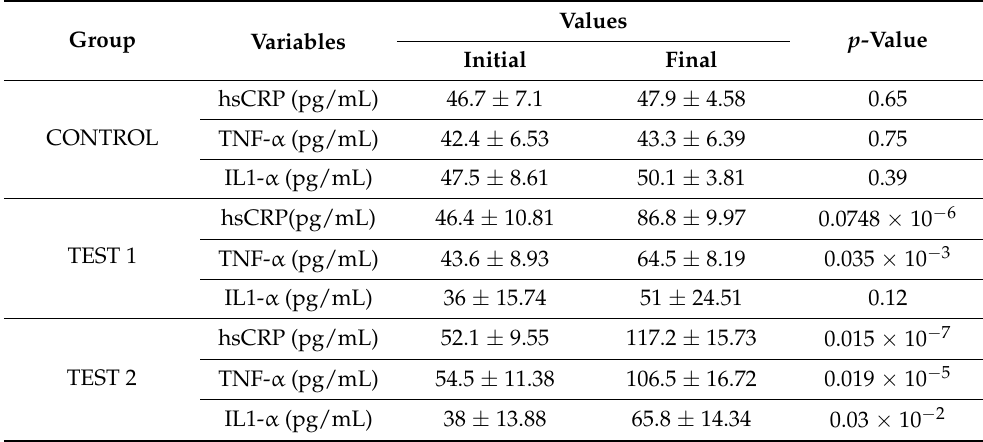
Table 2. Biochemical inflammatory markers, before and after periodontal disease induction.